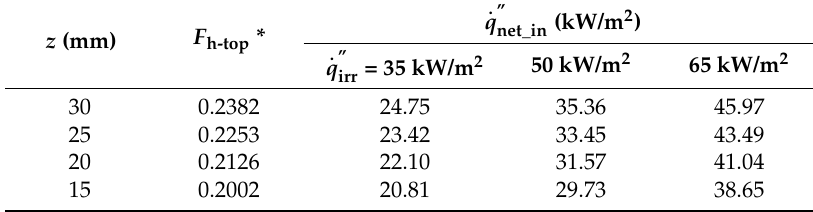
Table 3. View factors [38] and the corresponding true radiant heat absorptions ( 𝑞(cid:4662) (cid:2924)(cid:2915)(cid:2930)_(cid:2919)(cid:2924)(cid:4593)(cid:4593) ) at emissivity ( ε ) = 0.77.